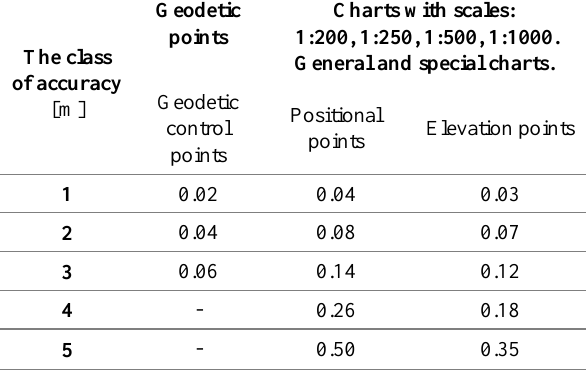
Table 1. The classes of accuracy according to the Slovak Technical Standards